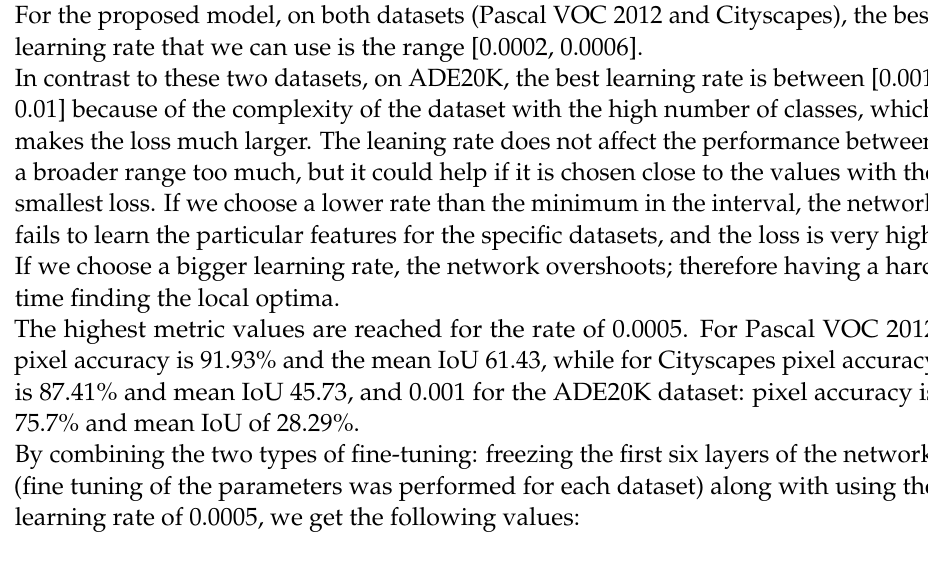
Table 11. Results after freezing the first n layers from the network. The best result is freezing after the fifth layer (which non-coincidently is after the second module of the network). Frozen